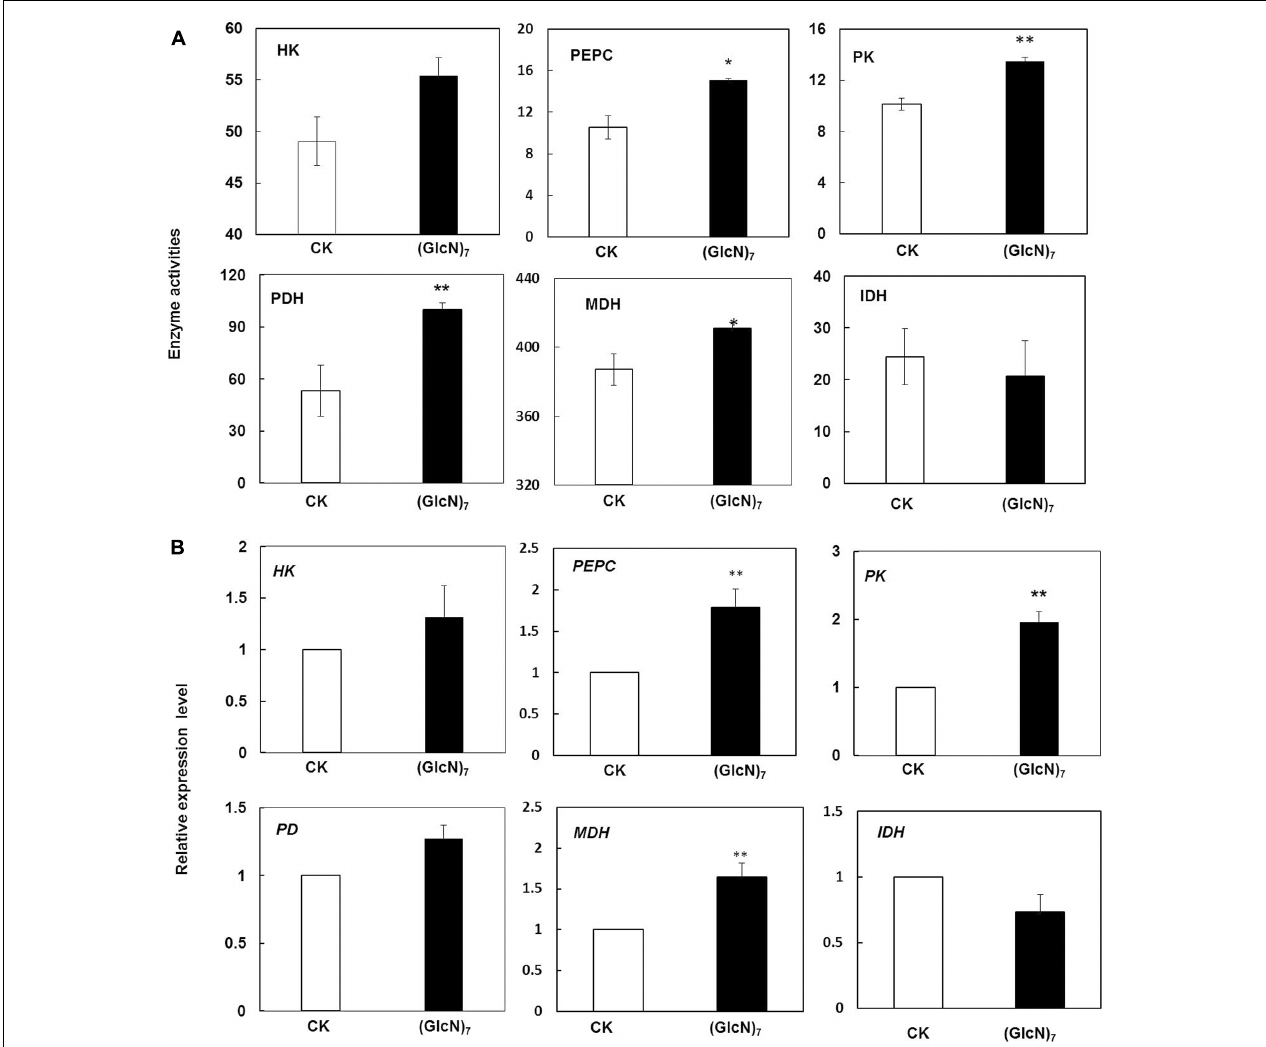
FIGURE 5 | Impacts of (GlcN) 7 on glycolysis and TCA cycle of wheat seedlings. (A) Key enzymes activities in glycolysis and TCA cycle. PEPC and PK activities are expressed as nmol s − 1 g − 1 FW and HK, PDH, MDH and IDH activities are expressed as µ mol min − 1 g − 1 FW. (B) Relative expression level of key enzymes in glycolysis and TCA cycle. Relative expression levels are calculated and normalized using β -actin as an internal control. Each value represents means ± SD calculated from four independent biological replicates. Significant differences from the CK are shown ( ∗ P < 0.05, ∗∗ P < 0.01; t